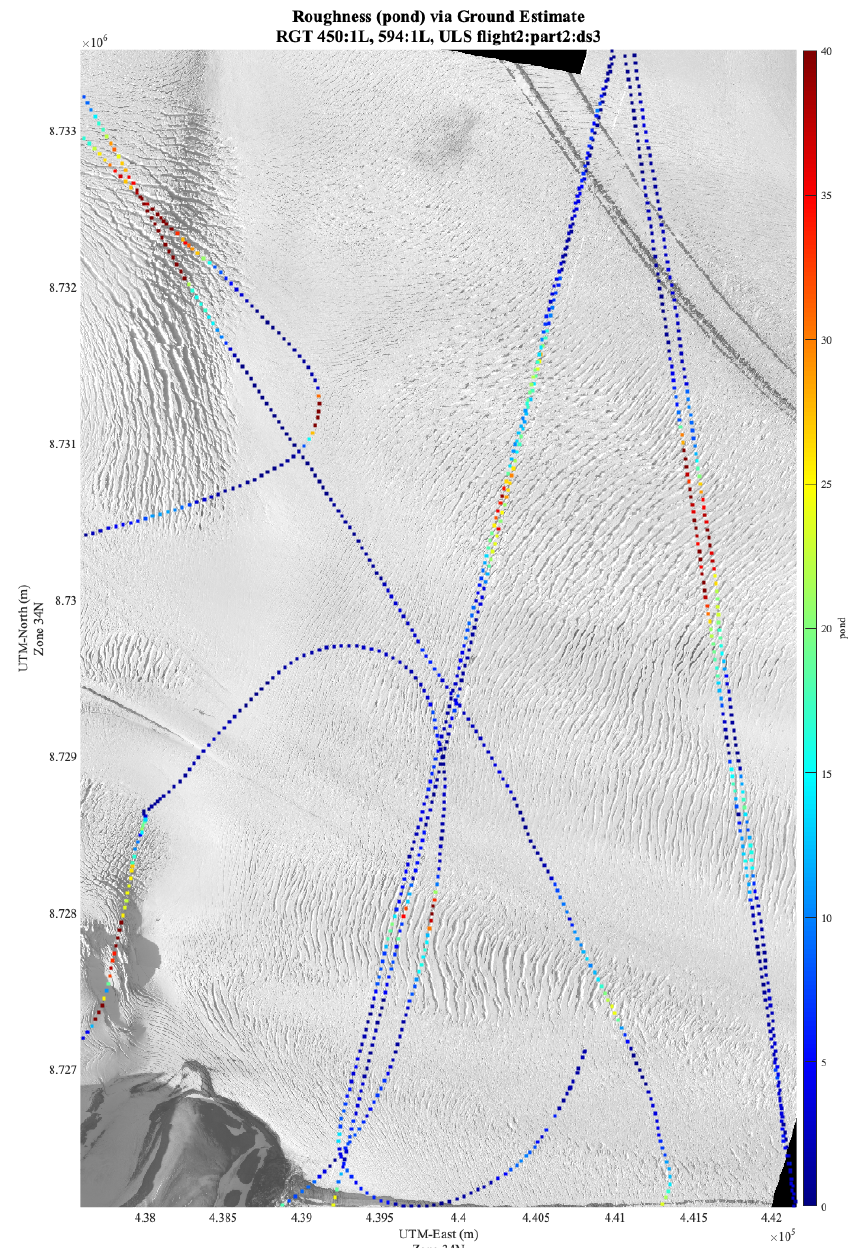
Figure 15. Ice-surface roughness in upper Negribreen during surge in 2019, from airborne al- timeter data (ULS) data and ICESat-2 ATLAS Data, compared to Planet SkySat image data. ICESat-2 ATLAS Granules: [ATL03_20190805232841_05940403_002_01.h5] [RGT 594 gt1l 5 Au- gust 2019] and [ATL03_20190727132129_04500405_002_01.h5] [RGT 450 gt1l]. SkySat Image [20190818_150858_ssc9_u0002_panchromatic_dn.tif]. SkySat ssc9 data have 0.72 m pixel size. Rough- ness measure pond res calculated for ICESat-2 ATLAS data, analyzed with the DDA-ice, and for ULS data. ICESat-2 RGT594 and matching ULS tracks are the right almost straight set; ICESat-2 RGT450 and matching ULS tracks are the left almost straight sets. For RGT 594, the airborne track (ULS) is to the east (right) of the satellite track. For RGT 450, the airborne track and the satellite track are almost in the same location. Generally, surface roughness from parallel tracks and crossover locations matches between ICESat-2 and ULS. The pond res measure increases with intensity of crevassing evident in the SkySat